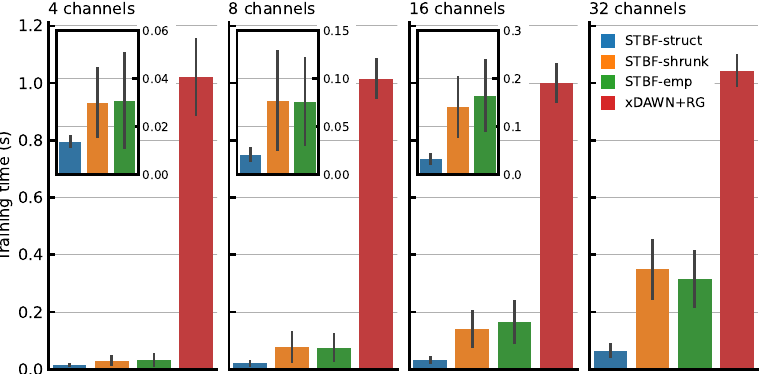
Figure 4. Median fold training time for different classifiers at different spatial resolution levels evaluated over all training folds for all subjects. Error bars represent standard deviation. The training time of STBF - SHRUNK increased more steeply with resolution compared to STBF - STRUCT . All STBF classifiers were able to be trained significantly faster than x DAWN + RG